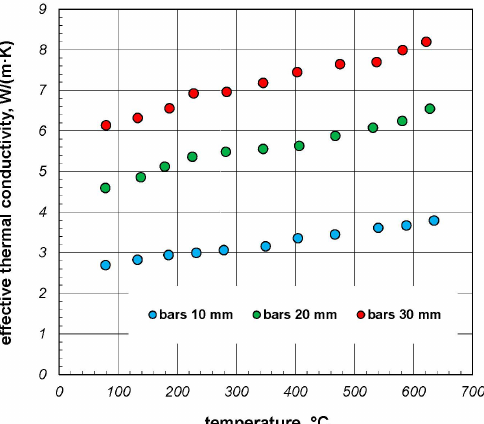
Figure 8. The effective thermal conductivity of square bar samples depending on the temperature and bar size.